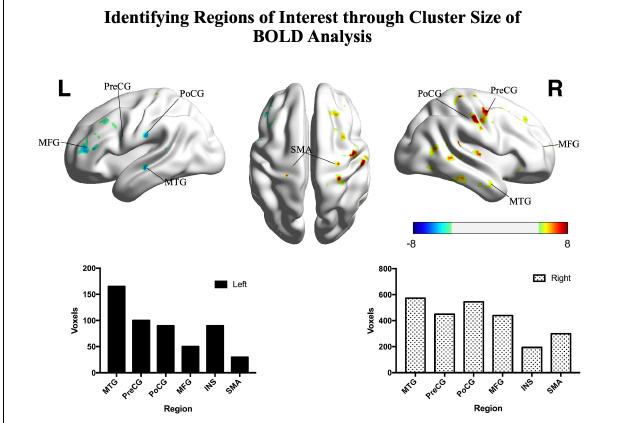
left and right networks (left vs. right, 0.59 ± 0.08 vs. 0.58 ± 0.07, p >